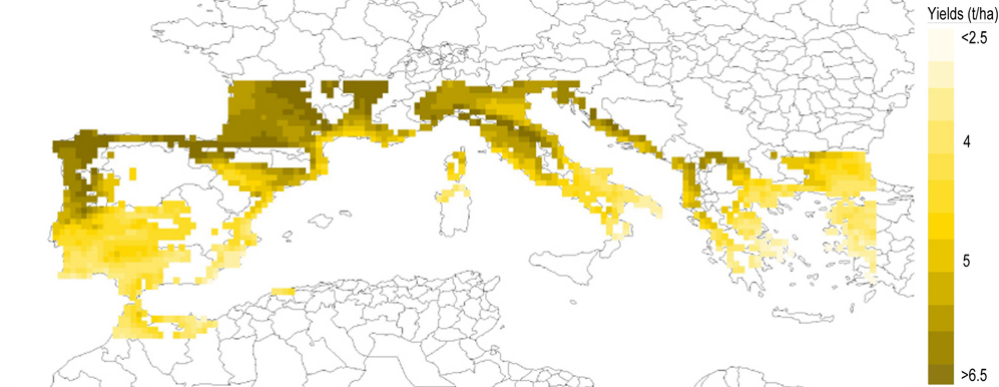
Fig. 3. Spatial distribution of the simulated 30-year mean durum wheat yield for the reference period (1961–1990) over the case study area.